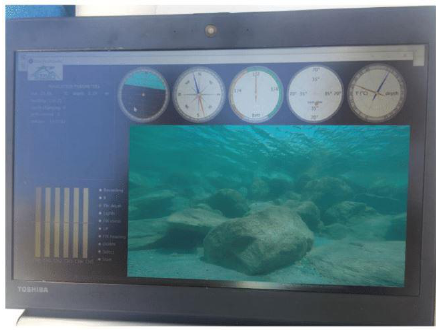
Figure 6. Display of ROV